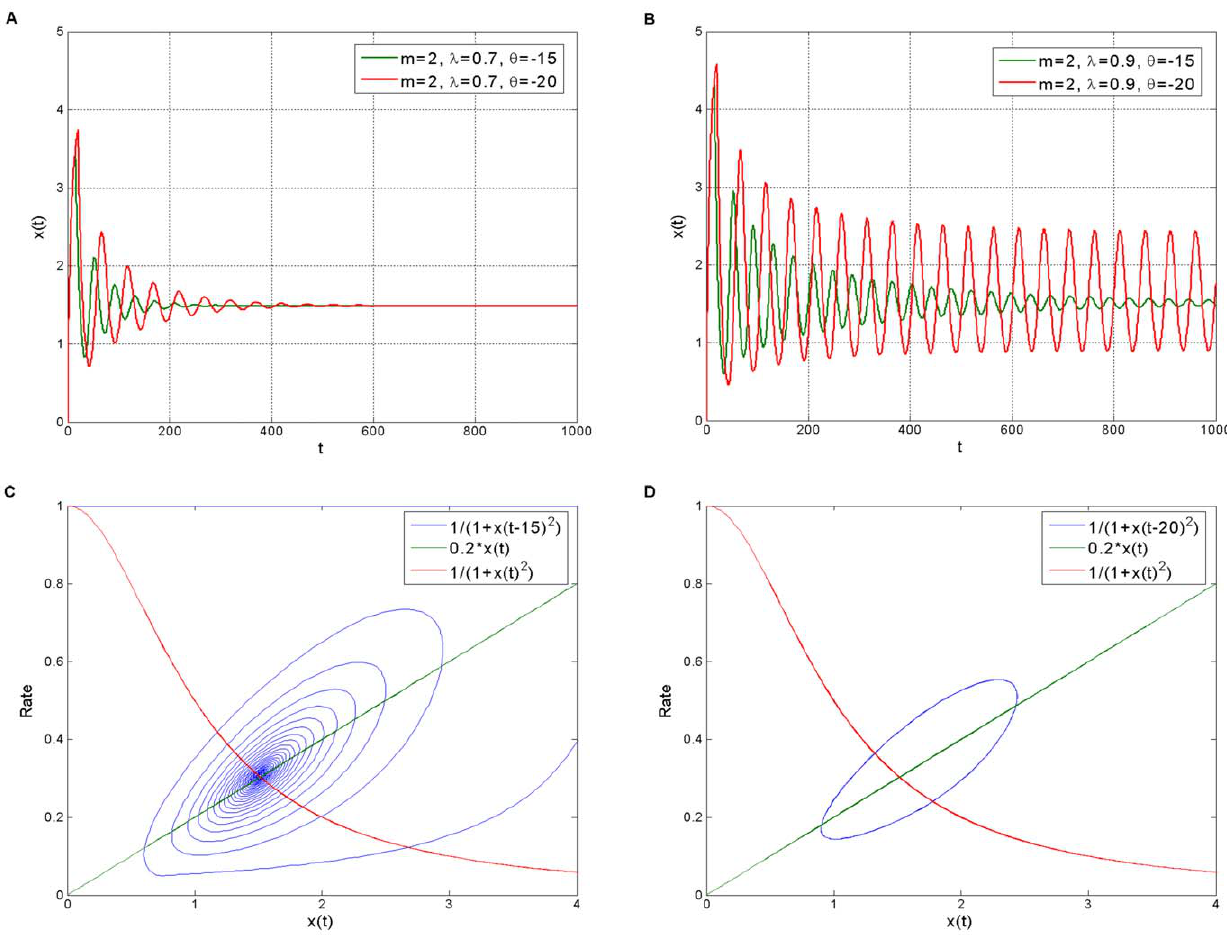
Figure 5. Numerical results of the fractional delay Goodwin oscillator. A. A comparison of the solutions of Eq. (17) with different time delay (–15 and –20, respectively) under the same condition of m ~ 2 , l ~ 0 : 7 and a ~ 0 : 2 . No sustained oscillations occur in both cases. B. Under the same condition of m ~ 2 , l ~ 0 : 9 and a ~ 0 : 2 , the solution of Eq. (17) with h ~{ 15 indicates a damped oscillation on the way to steady state, while the case with h ~{ 20 corresponds to sustained oscillation. C. Plots of the synthesis rate (without delay), the degradation rate and the rate of synthesis containing delay, against the present value x ( t ) . The blue curve indicates the damped oscillation. D. Plots of the synthesis rate (without delay), the degradation rate and the rate of synthesis containing delay, against the present value x ( t ) . The blue circle indicates sustained